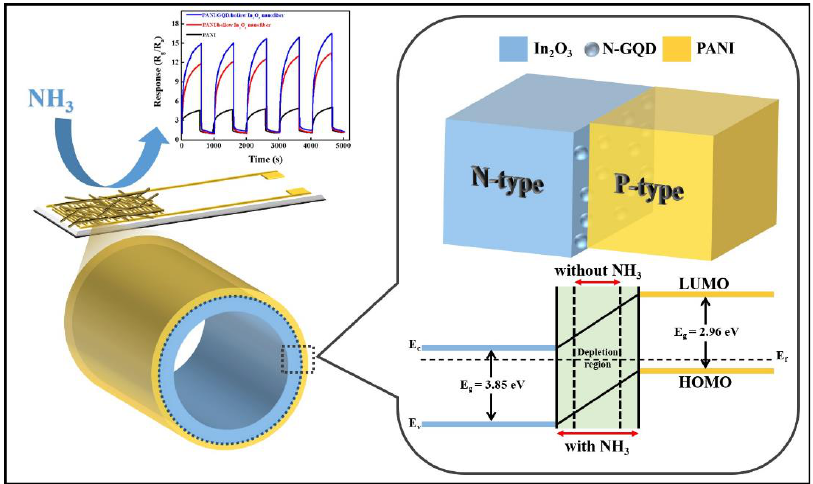
Figure 5. Representation of sensing mechanism of the N-doped GQDs for NH 3 gas detection. Reproduced from Hong, S.Z., Huang, Q.Y. and Wu, T.M., 2021. The room temperature highly sensitive ammonia gas sensor is based on polyaniline and nitrogen-doped graphene quantum dot-coated